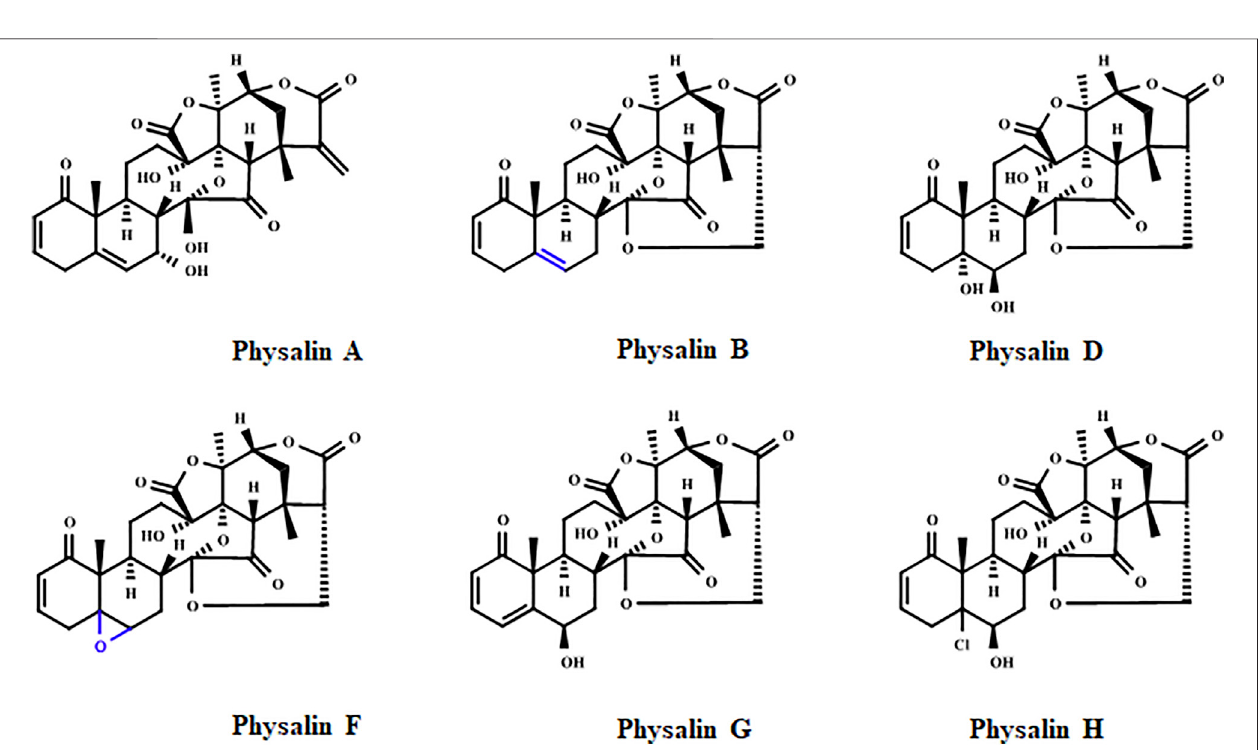
FIGURE2| ChemicalstructureofthephysalinsA,B,D,F,G,andH.TheepoxygroupofphysalinFandthedoublebondforphysalinB,whichmaycontributetothe potent cytotoxic effect of these physalins, are highlighted in blue.